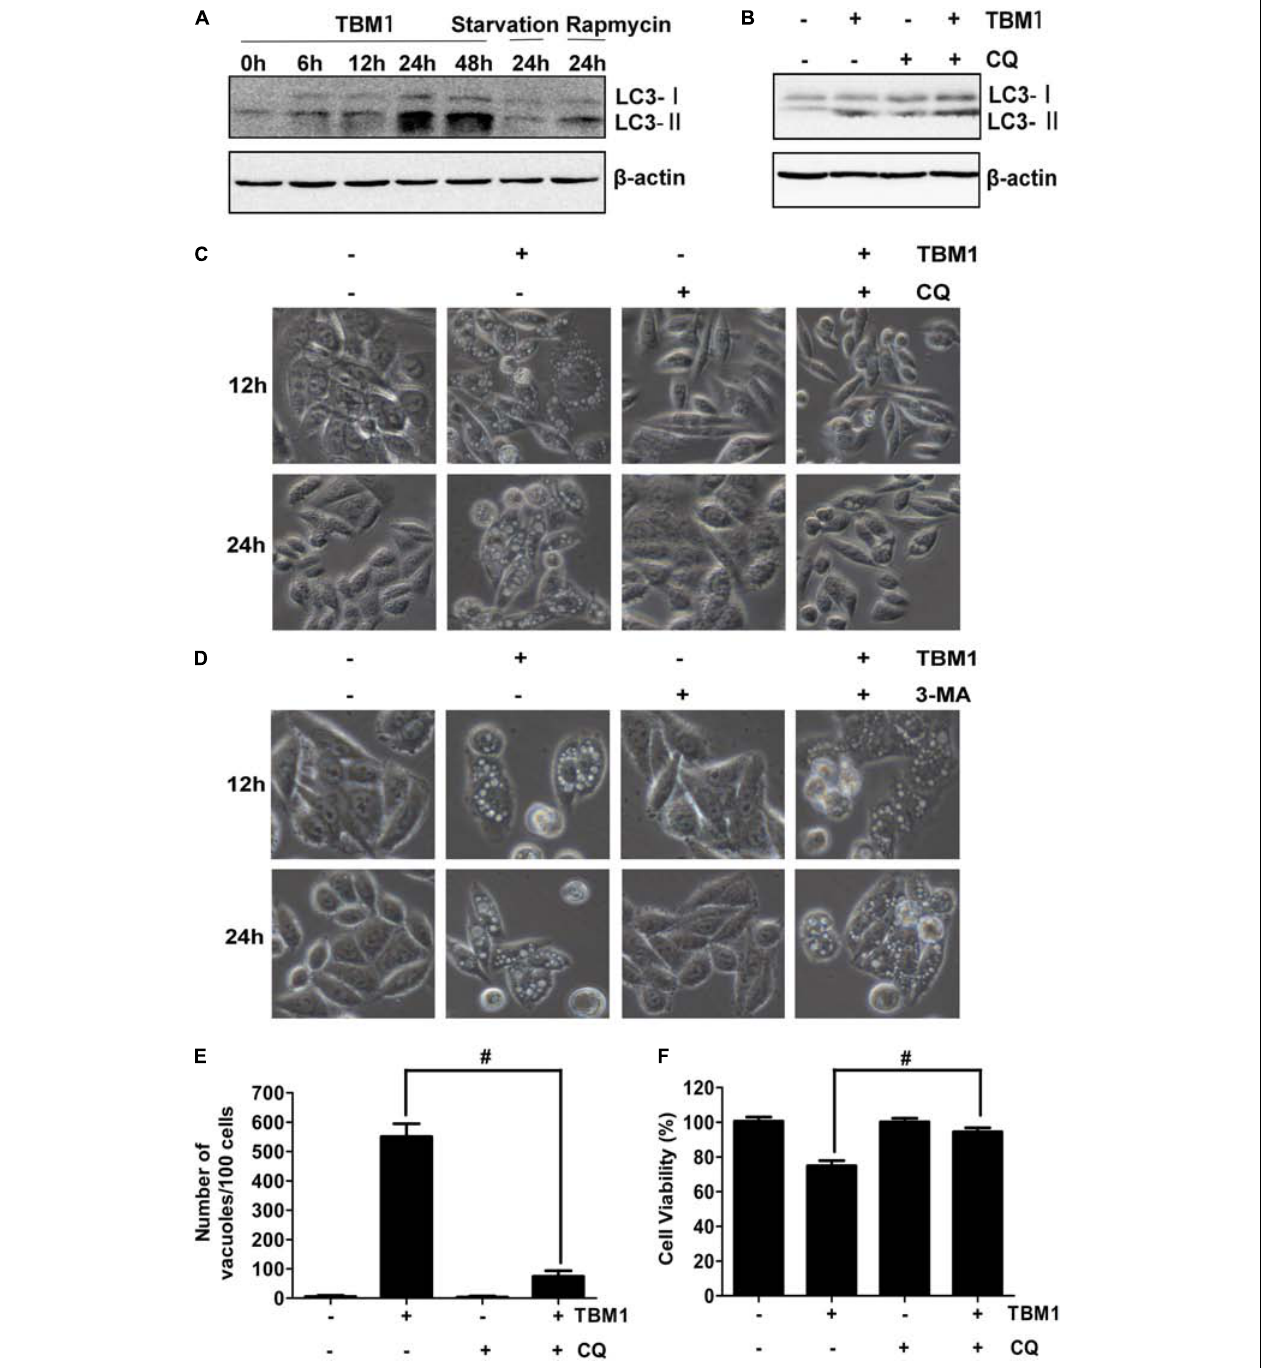
FIGURE 6 | Chloroquine suppress TBM1-induced vacuolation and cell death in CRC cells. (A) SW480 were treated with 8 µ M TBM1 for different time or starvation or 1 µ M rapamycin for 24 h. Protein expression of LC3-I and LC3- II was detected by Western blotting. Beta-actin were served as loading control. (B) SW480 cells were pre-cultured with or without chloroquine (CQ) (10 µ M) for 1 h before exposure to TBM1 for 24 h. LC3 processing was assessed using Western blotting analysis. (C) After treatment with SW480 cells for different time as (B), morphological changes were observed by phase-contrast microscopy. (D) SW480 cells were pre-cultured with or without 3-MA (3 mM) for 1 h before exposure to TBM1 for different time. Morphological changes were observed using phase-contrast microscopy. (E) The number of vacuoles of the same cultures as (B) for 48 h was counted from three different imagines. (F) Cell viability was measured by MTT assay ( n = 5). # p <